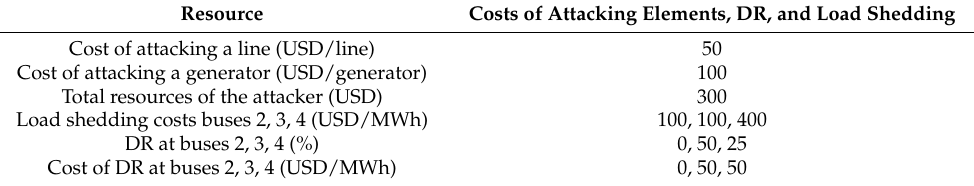
Table 4. System resources.